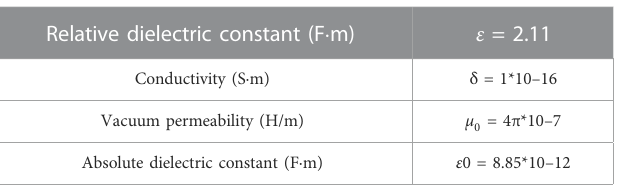
TABLE 2 The properties of XLPE.